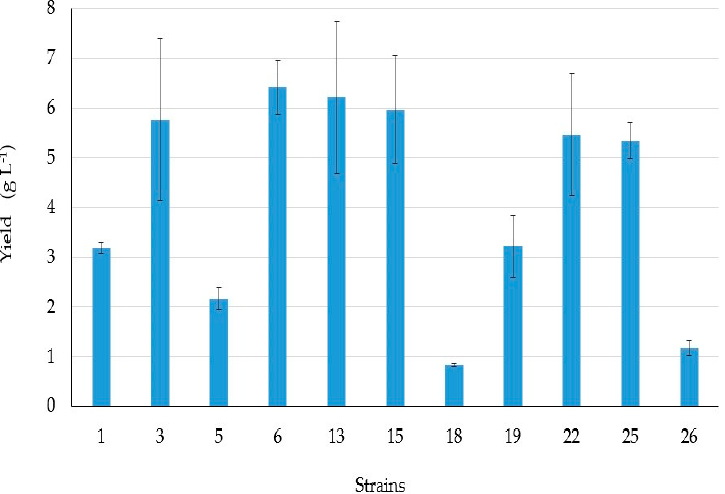
Figure 3. Yield of BS extracts (g L –1 ) from intestinal bacterial cell-free supernatants. Error bars indicate standard error (SE).